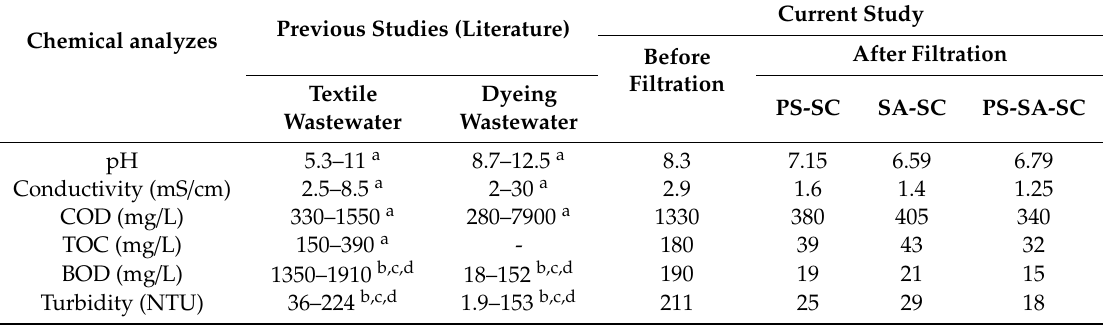
Table 5. Chemical analyzes of wastewater before and after filtration and comparison with literature